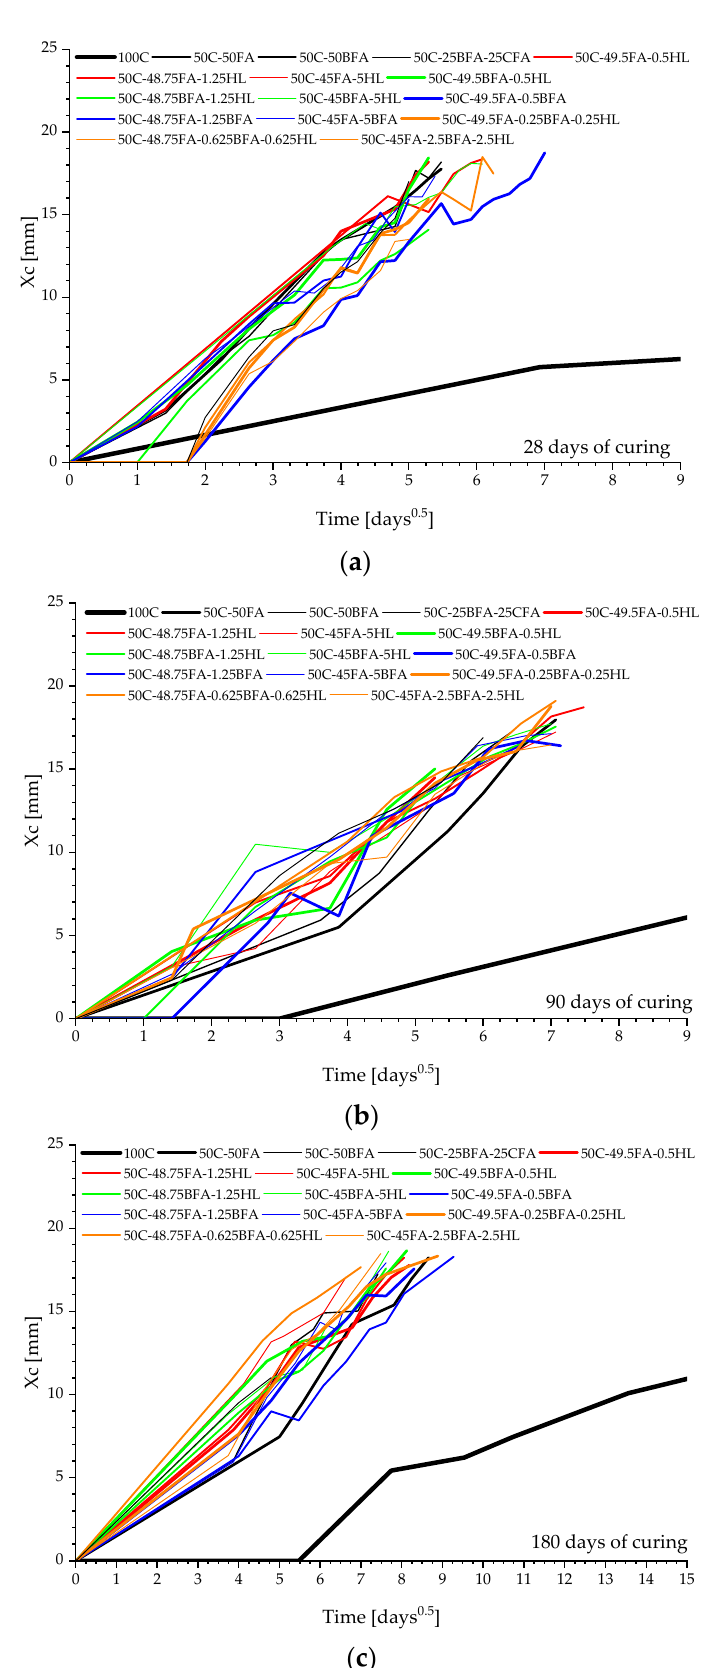
Figure 9. Carbonation depth measured in mortars with ( a ) 28, ( b ) 90, and ( c ) 180 days of curing.